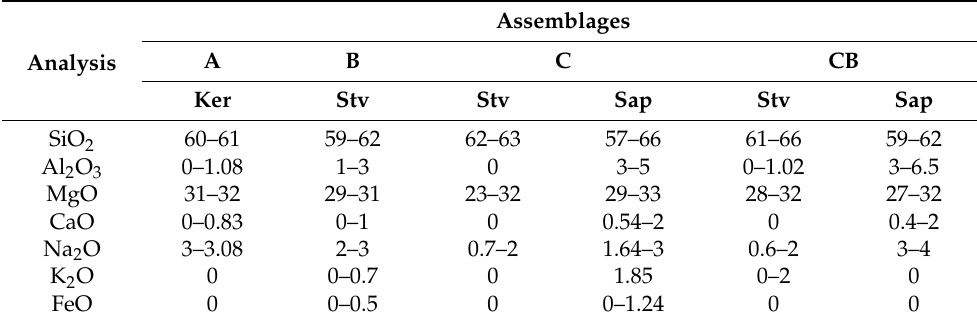
Table 2. Average ranges of chemical EDS point analyses (oxide wt%) from representative samples of the different assemblages established. Kerolite (Ker), stevensite (Stv) and saponite